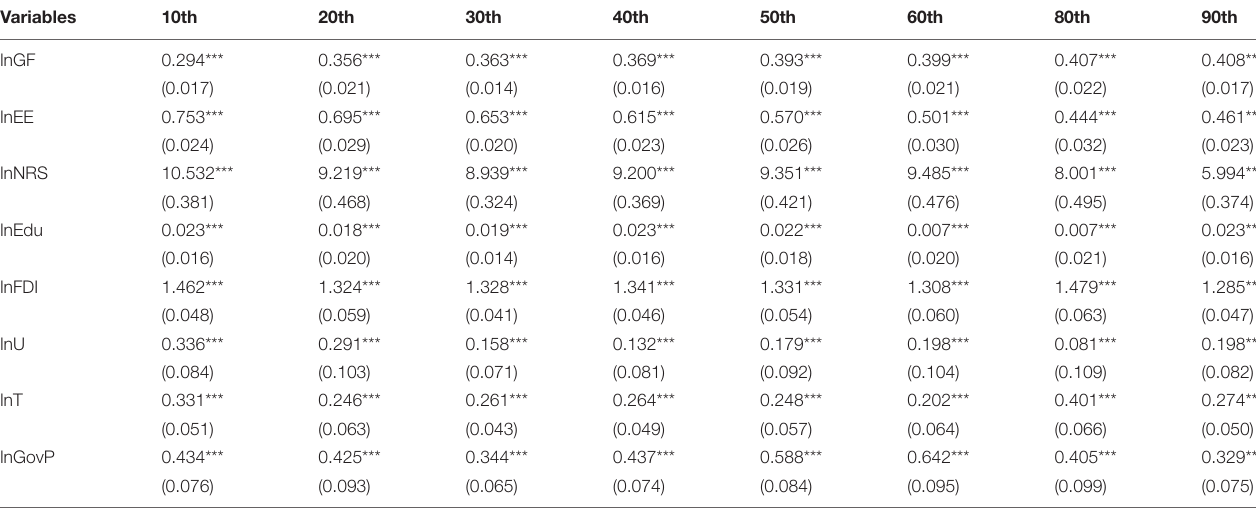
TABLE 5 | The impact of Green finance, government expenditure, and energy efficiency on energy poverty. Variables